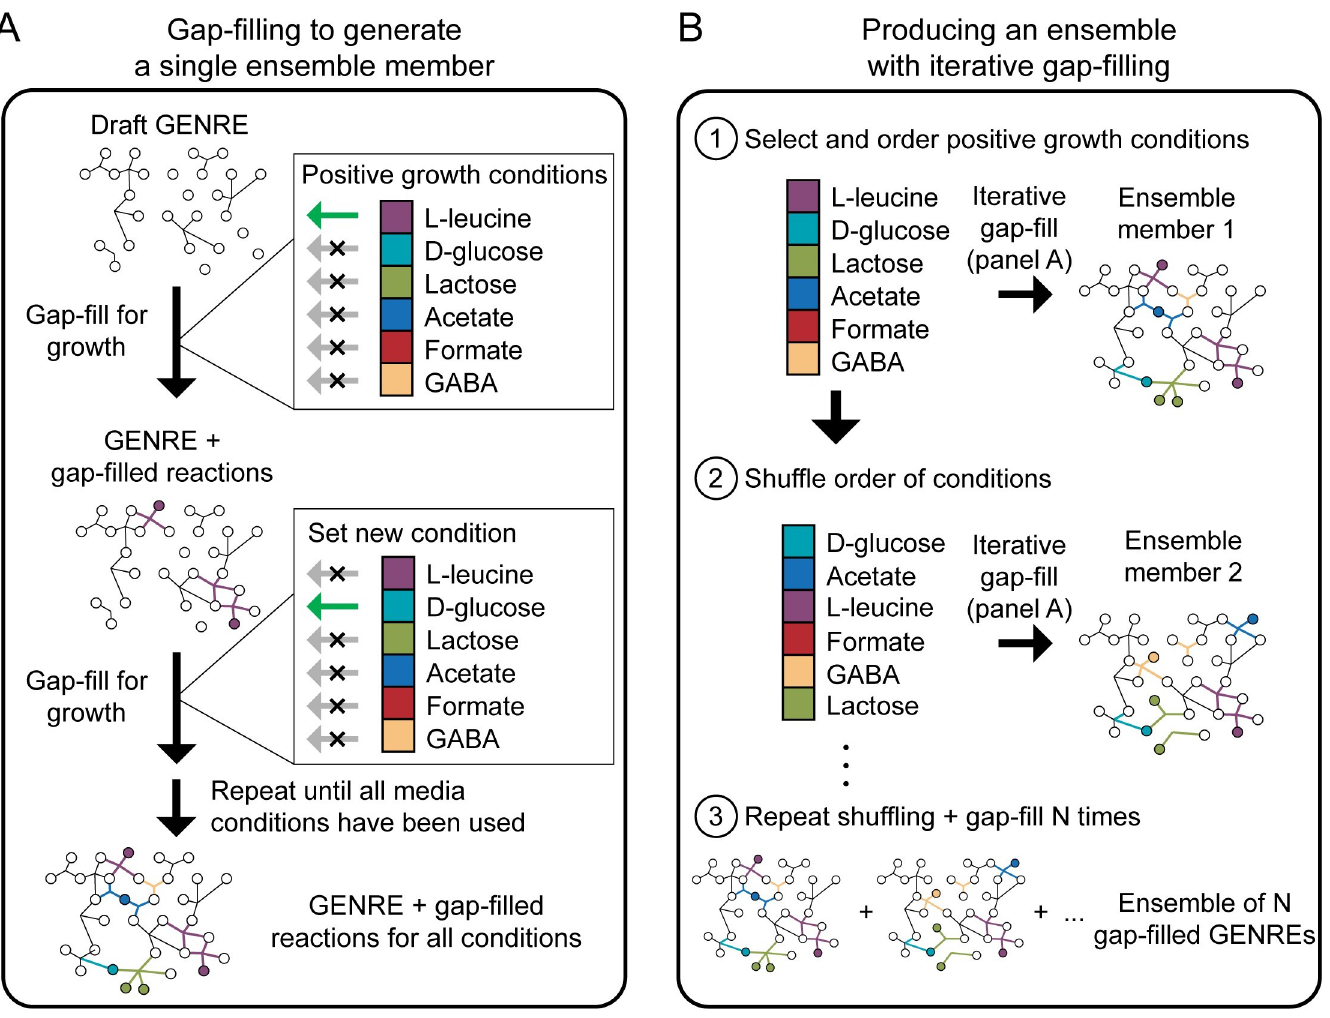
Fig 3. Iterative gap-filling strategy used to generate ensembles implemented in Medusa. A) Given a list of conditions in which an organism satisfied some objective (e.g., secretion of a specific metabolite, growth) and a draft GENRE for the organism, gap-filling is performed sequentially on each condition. After each gap-fill step on a single condition, reactions in the gap-fill solution are added to the GENRE before starting gap-filling on the next condition. In this schematic, all conditions are used, but Medusa also allows users to randomly subsample a fraction of conditions to generate more variation in the resulting gap-filled GENREs. Here, gap-filling is performed to enable growth in the presence of each individual metabolite (indicated by a green arrow for a single condition during each gap-fill step). B) Medusa iteratively performs gap-filling as shown in panel A , then shuffles the order of conditions to introduce variation in the gap-fill solution. After a user-defined number of cycles through the process shown in panel A , Medusa generates an ensemble containing all unique GENREs that resulted from gap-filling.